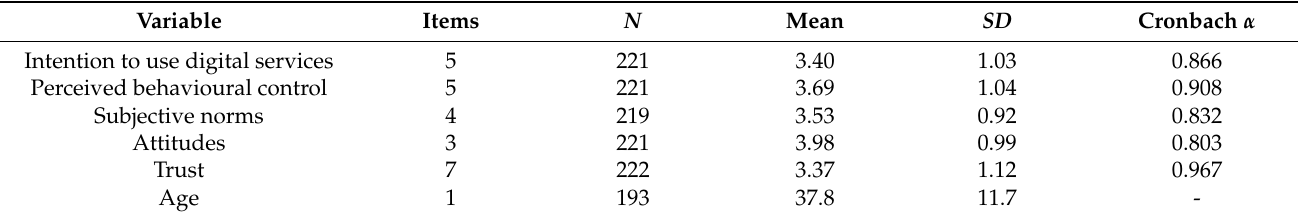
Table 1. Variables included in the research design and their means, SD and reliability.